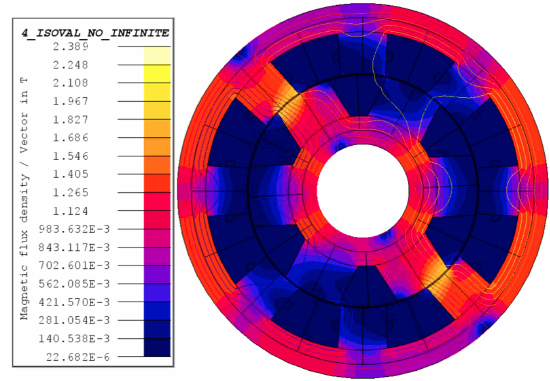
Figure 2. Magnitude of the magnetic field density B ( A z ) under fault